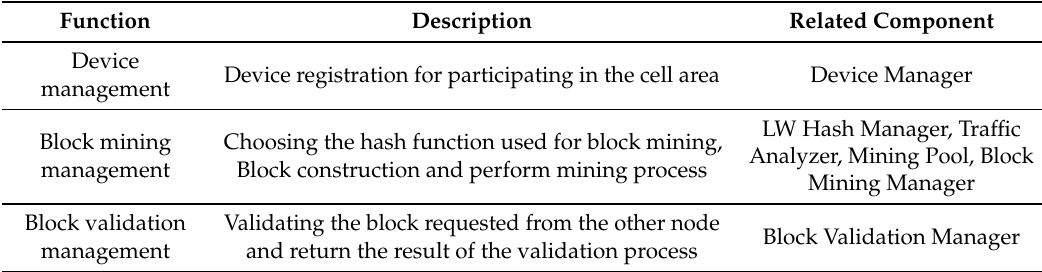
Table 3. Functions and related component of the cell